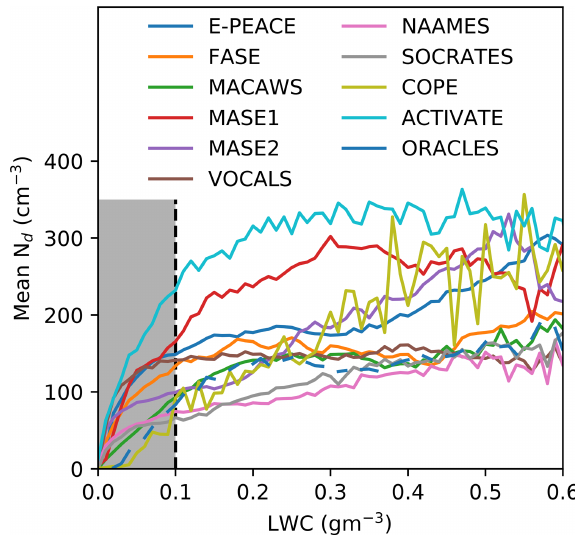
Figure 2. Average aircraft N d as a function of LWC. Aircraft data with an LWC less than 0.1gm − 3 are excluded from this